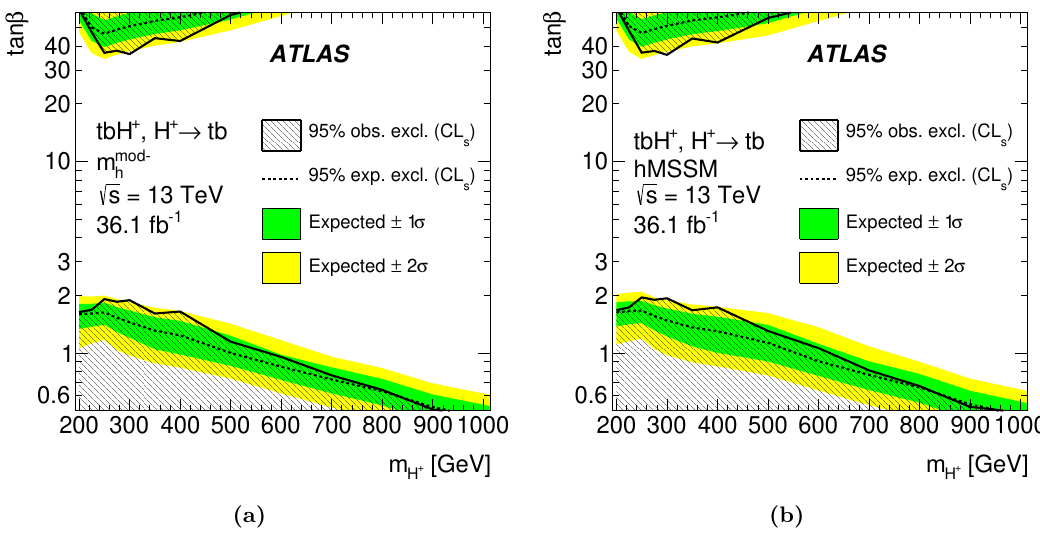
Figure 9. Expected and observed limits on tan (cid:12) as a function of m the hMSSM [29] (right) scenarios of the MSSM. Limits are shown for tan (cid:12) values in the range of 0.5{60, where predictions are available from both scenarios. The bands surrounding the expected limits show the 68% and 95% con(cid:12)dence intervals. The limits are based on the combination of the ‘ +jets and ‘‘ (cid:12)nal states. The production cross-section of t (cid:22) tH and tH , as well as the